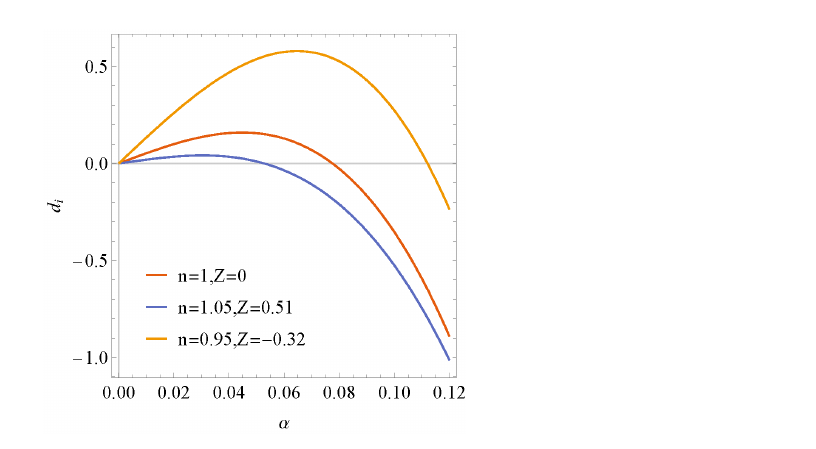
Figure 3. Linear amplitude growth rate of disturbed waves for various n and Z at Re = 10.